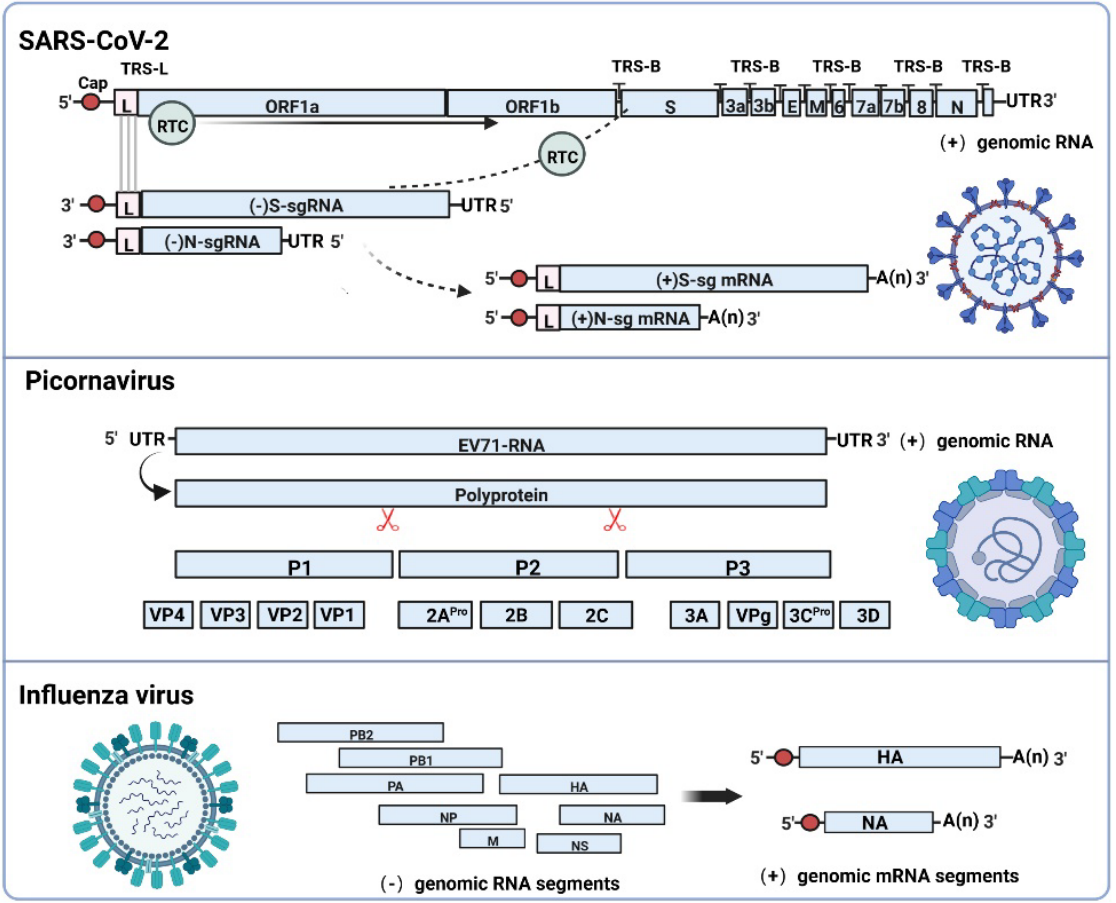
Figure 1. Comparison of transcription patterns of positive or negative strand viruses possessing genomes of different lengths. SARS-CoV-2 ((+) strand RNA virus) utilizes RTC (RdRP-formed complex) and TRS for discontinuous transcription to generate ( − ) strand subgenomic RNAs, which are used as translation templates for the synthesis of (+) strand subgenomic mRNAs. Picornaviruses with smaller genomes, such as enterovirus EV71, directly translate genomic RNA into multimeric proteins, which are cleaved into structural and nonstructural proteins. Influenza virus (( − ) strand RNA virus) use itself as a template to synthesize the positive strand, which is transcribed into mRNA. Image created with BioRender (https://biorender.com/ (accessed on 8 August 2022). 3. The Effect of Subgenome Composition and Encoded Proteins on the Replication Ability of Virus Variants A new mutation occurs every 10,000 nucleotides during RNA virus replication. The mutation rate of RNA viruses is 1,000,000 times higher than that of DNA viruses [54]. SARS-CoV-2 undergoes adaptive evolution caused by multiple factors, including nucleo- tide mutations and vaccine-induced immune stress during virus replication. The main drivers of SARS-CoV-2 variants lie in nucleotide sequence mutations, probably due to single-nucleotide polymorphisms (SNPs), insertions or deletions (INDELs) caused by dis- continuous subgenomic RNA synthesis, and RNA modifications or editing driven by po- tential host factors, resulting in changes in viral replication capability, transmissibility, pathogenicity, and antigenicity[55]. (Figure 2) For example, single-nucleotide mutation sites of the Omicron variant are mainly located in the spike protein. There are approxi- mately 32 mutation sites in this variant, including 30 base substitutions, 6 base deletions, and 3 base insertions [56], which increase the risk of reinfection and tolerance to vaccines. It has been reported that the complex encoded by nsp10–14 can remove misincorporated nucleotides or nucleotide analogs to improve the fidelity of RNA synthesis, proofreading the mismatched bases during RNA synthesis. Nsp14 is a bifunctional enzyme composed of an exonuclease (ExoN) domain and a methyltransferase (MTase) domain, which plays an important role in the replication and translation of SARS-CoV-2 [57]. For example, SARS-CoV-2 can affect the activity of nucleotide analog inhibitor antiviral drug remdesivir, which inhibits RdRP and significantly blocks coronavirus replication through nsp14 proofreading. RNA-dependent RNA polymerase (RdRP) is a key component of vi- ral replication and transcription. Nucleotide incorporation errors mediated by RdRP